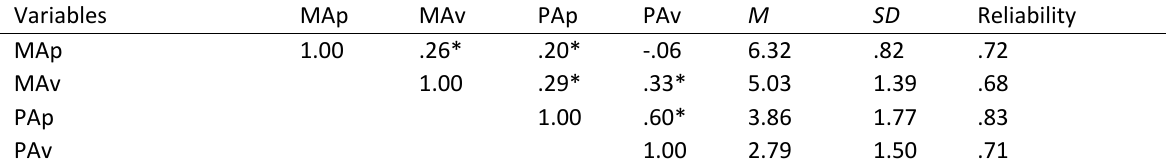
Table 1. Correlations, means, standard deviations, and reliability coefficients for the entire sample Variables